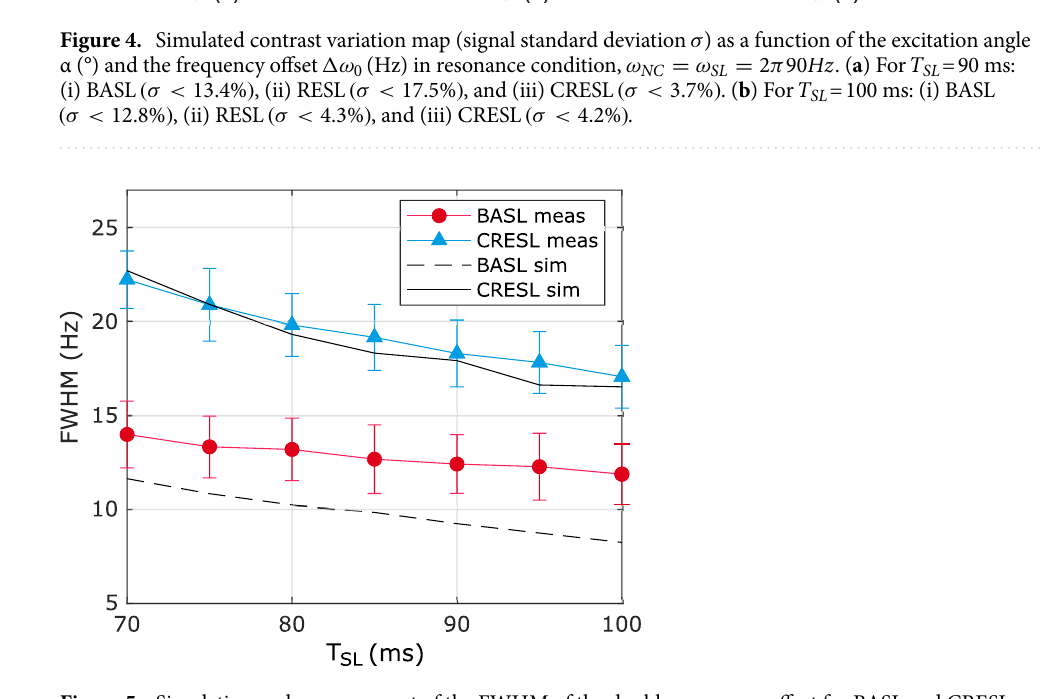
Figure 5. Simulation and measurement of the FWHM of the double resonance effect for BASL and CRESL preparations as a function of T SL . For both cases B NC = 75 nT, ω SL = 2 π 90